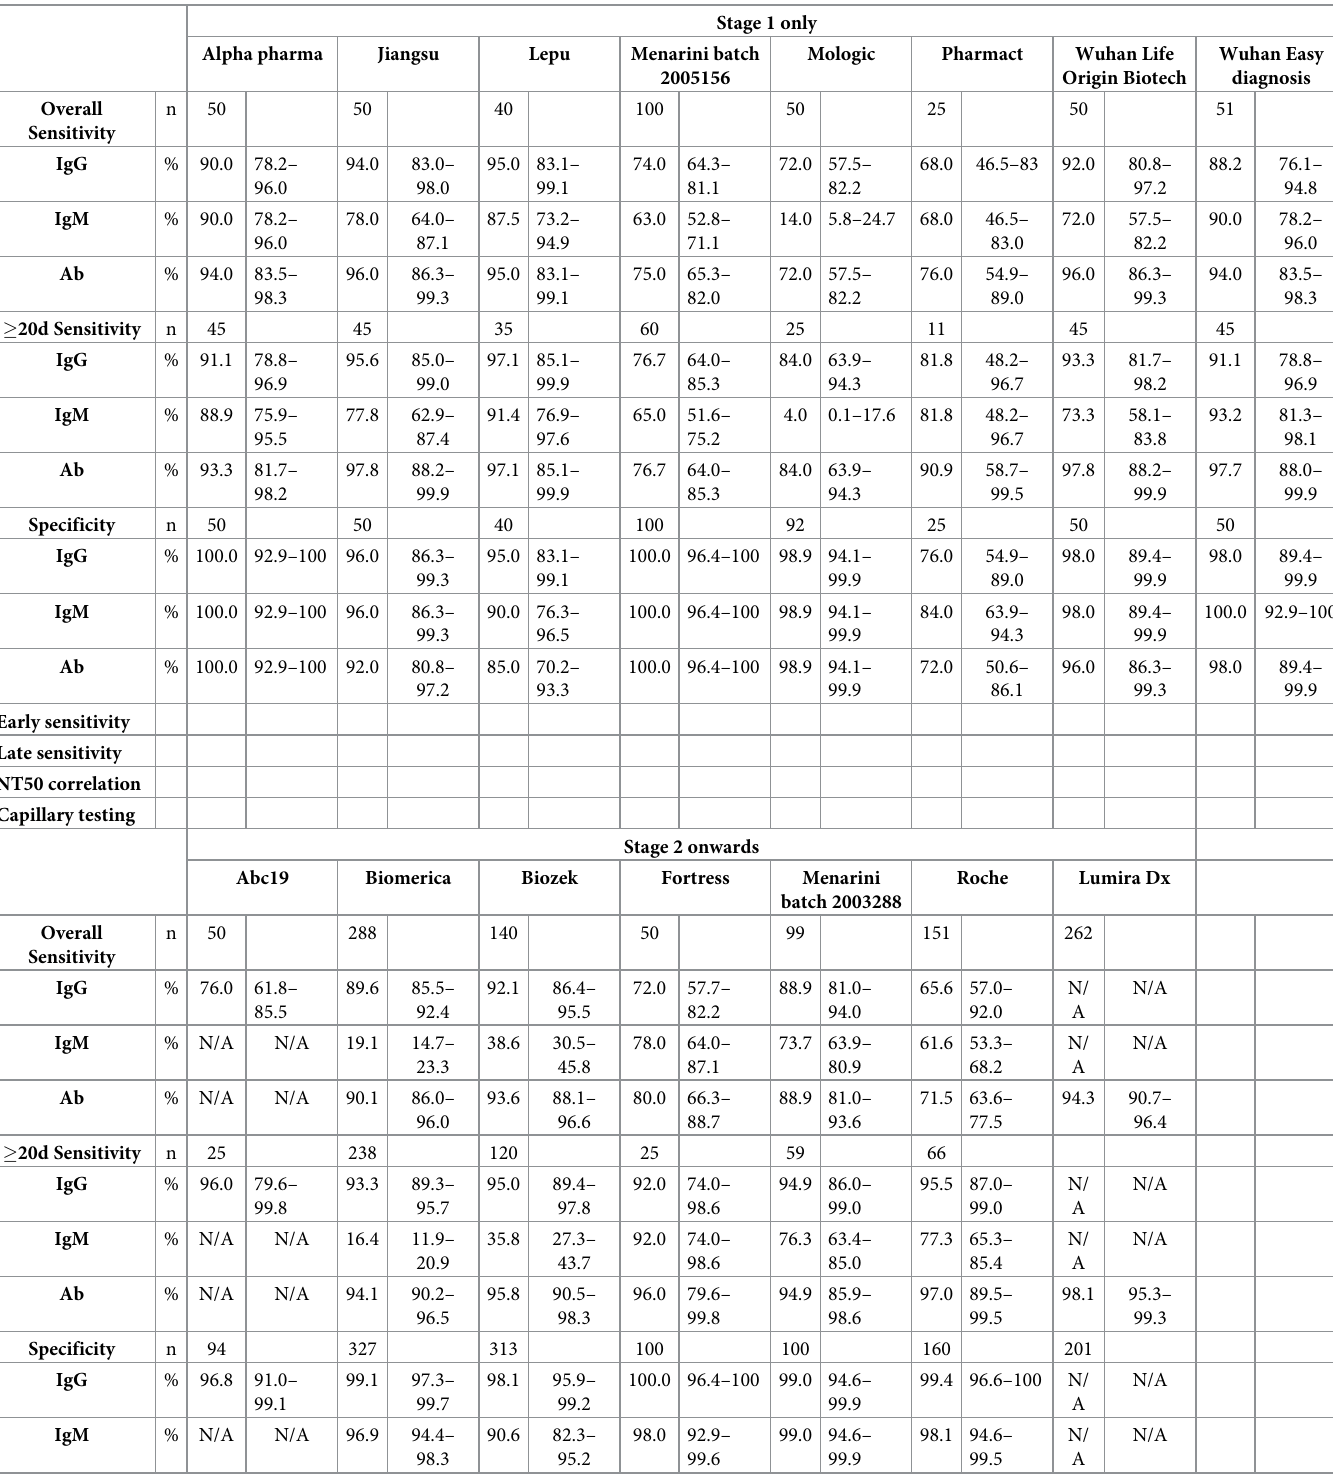
Table 1. Summary of POC test sensitivity and